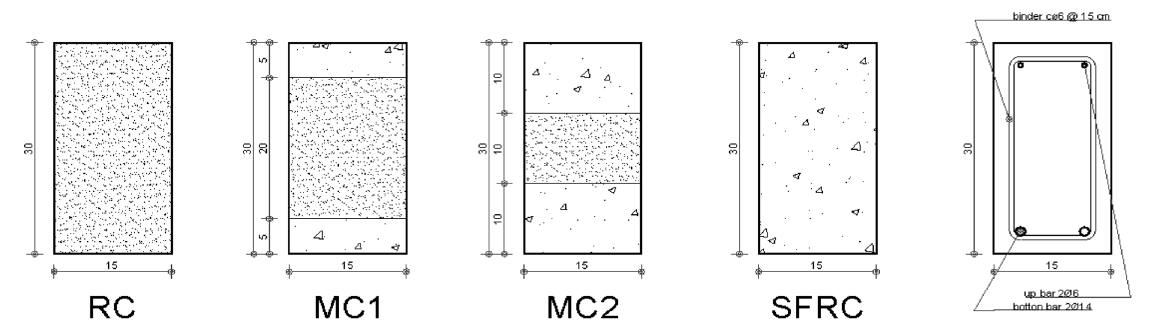
Fig. 1. Cross-section and reinforcement of the tested beams